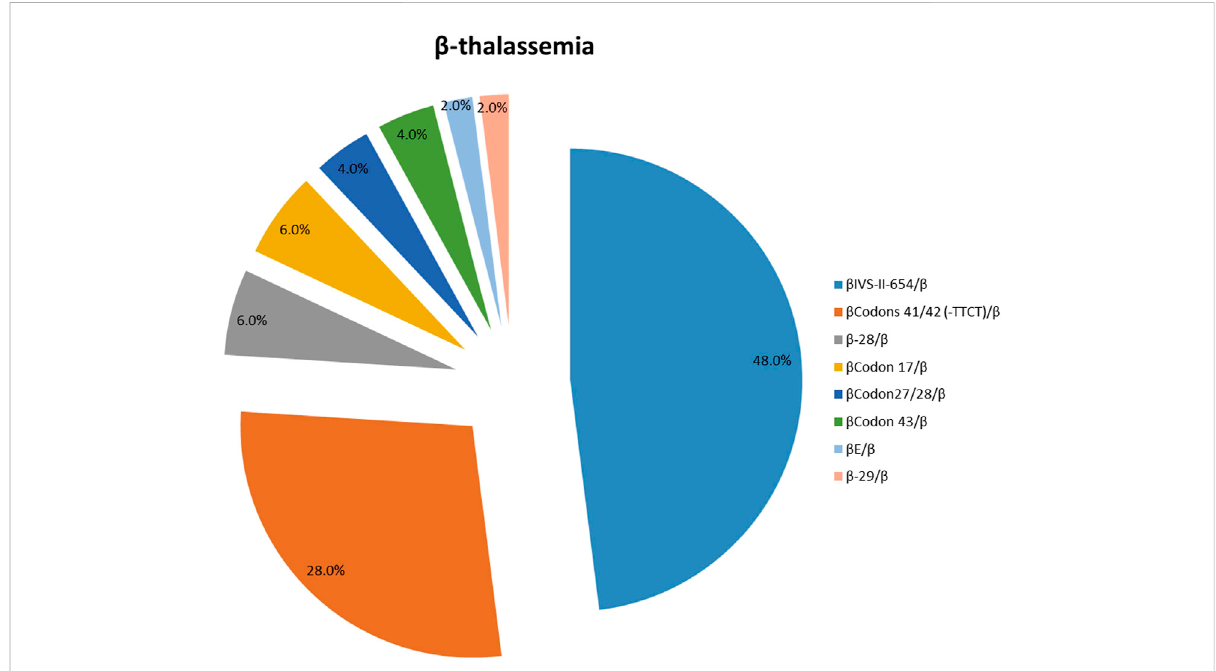
FIGURE 4 The prevalence of molecular genetics spectrum among β -thalassemia breast cancer patients in Jiangxi province. β IVS − II − 654 / β was the most common genotype, accounting for 48% of all β -thalassemia genotypes.